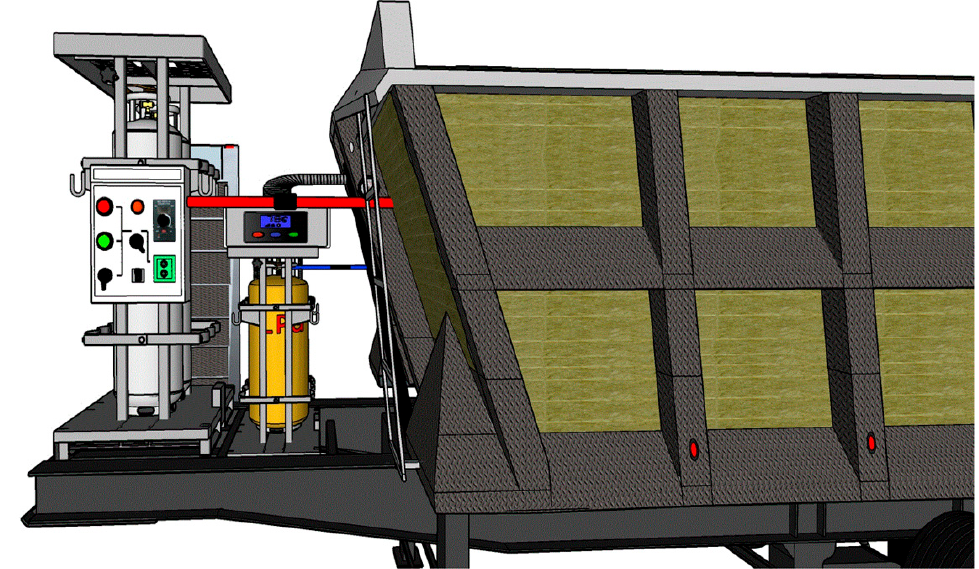
Figure 3. Thermal treatment for pathogen inactivation by a direct-fired heater using propane (yellow cylinder) injecting heat to the trailer headspace with carcasses.